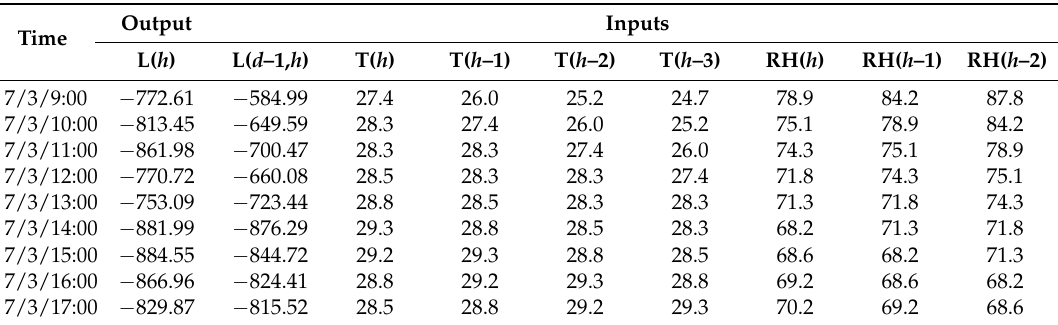
Table 2. Some examples of training samples.